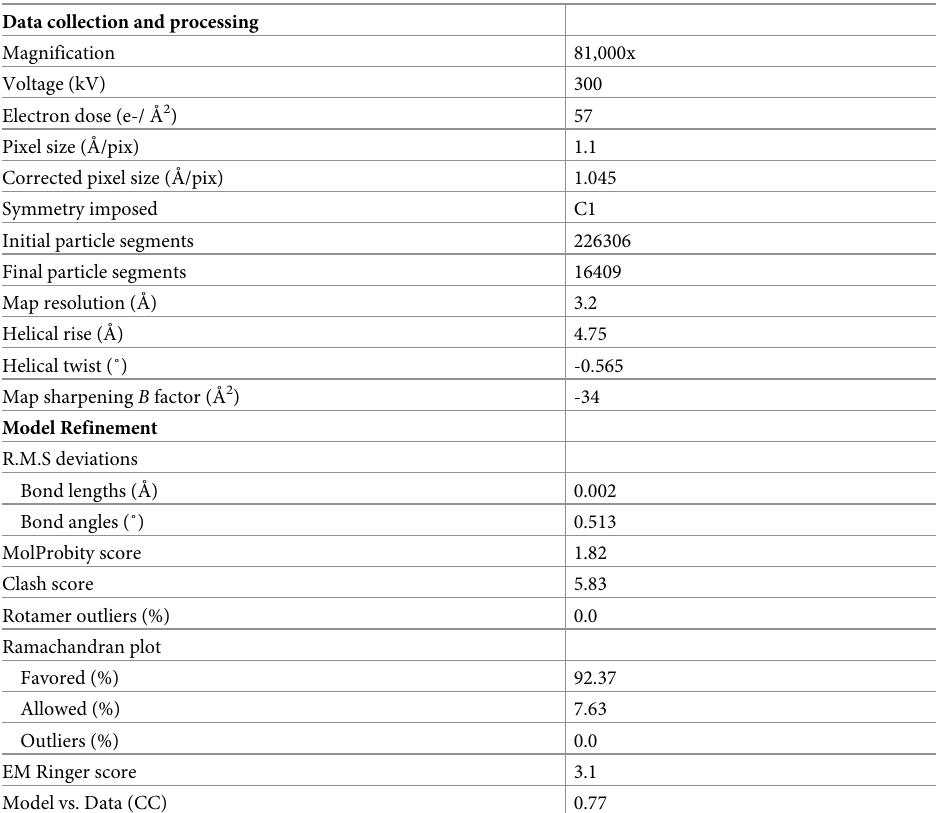
Table 1. Cryo-EM data, refinement, and